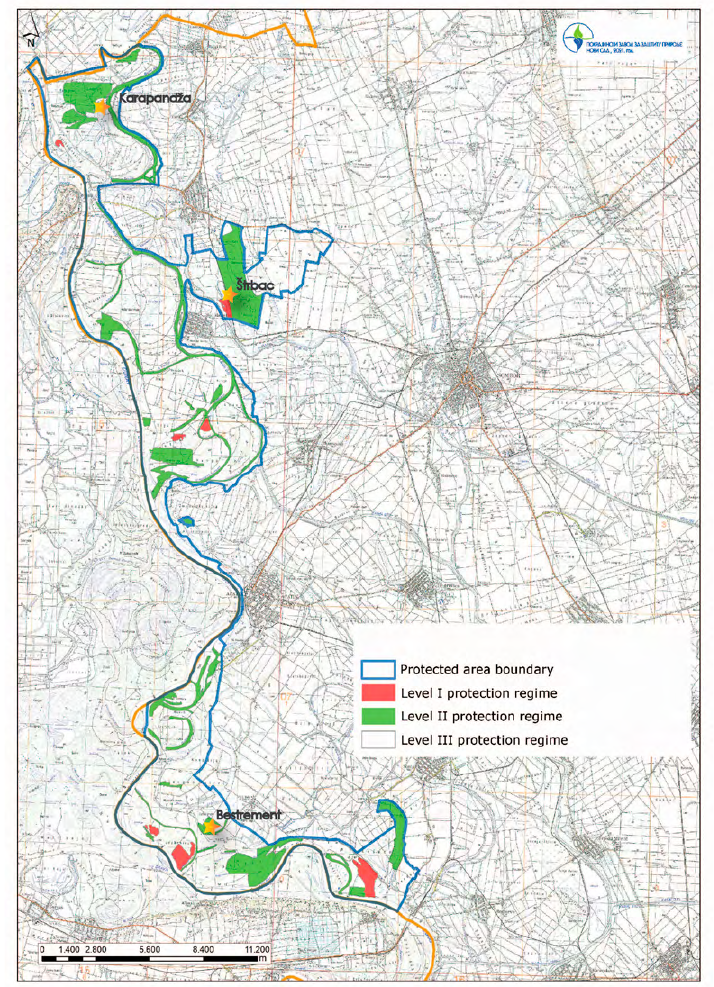
Figure 1. Special Nature Reserve “Gornje Podunavlje” [click on figure to